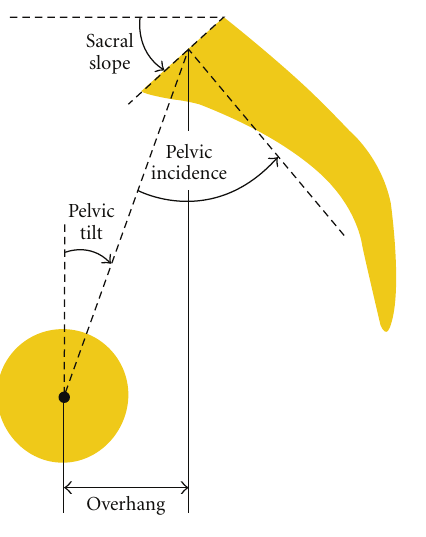
Figure 2: Pelvic parameters.